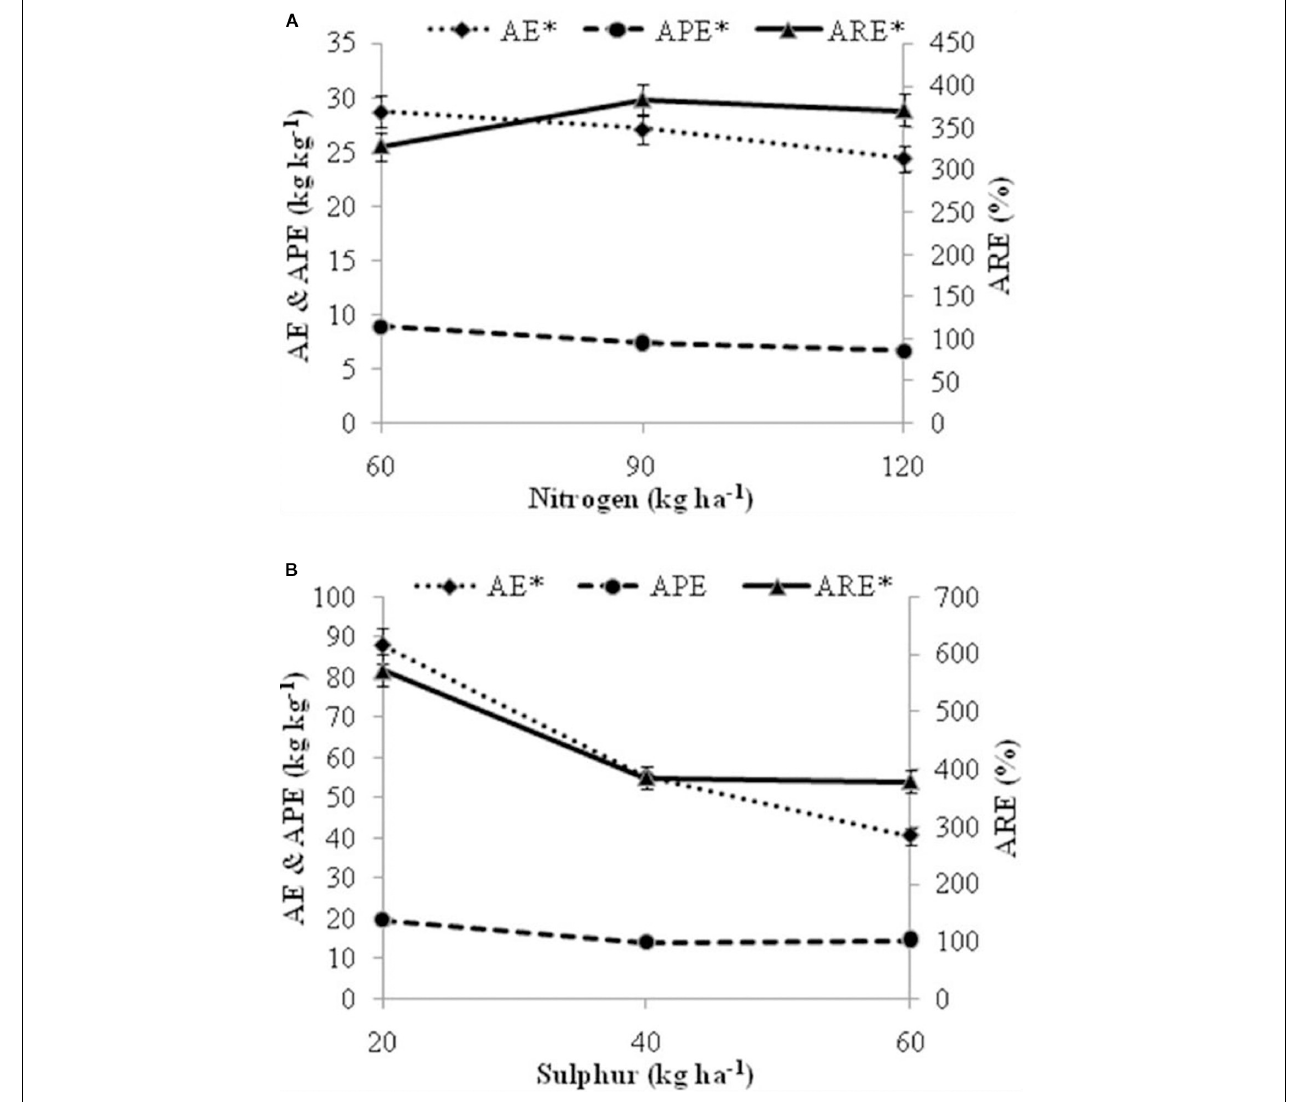
FIGURE 8 | Effect of fertilization levels (A) levels of nitrogen (B) levels of sulfur on nutrient efficiency traits viz. AE, Agronomic efficiency; APE, Agro physiological efficiency; ARE, Apparent recovery efficiency. The mean values of 2 years pooled data are presented. Asterisk (*) on nutrient efficiency traits indicates significant differences among fertilizer levels at P = 0.05. Vertical bars indicate a mean standard error ( ±